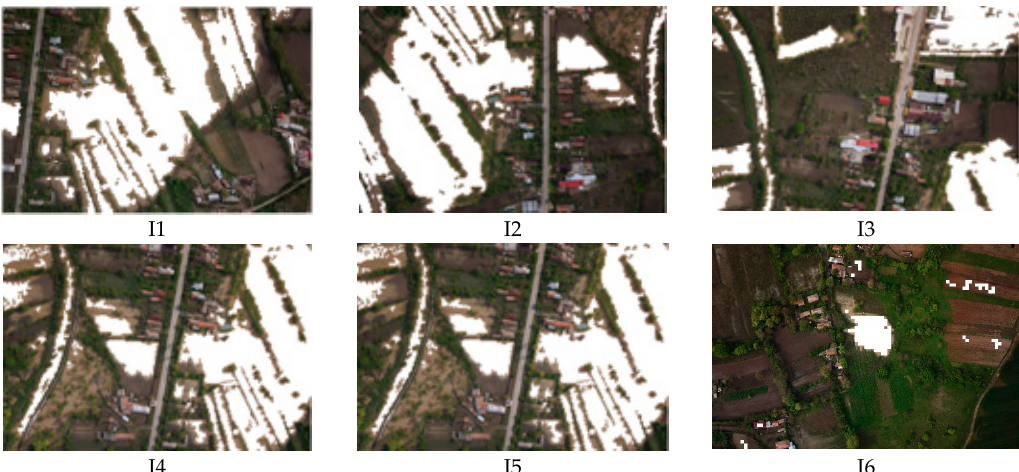
Figure 12. The overlap of RGB images with the segmented images.